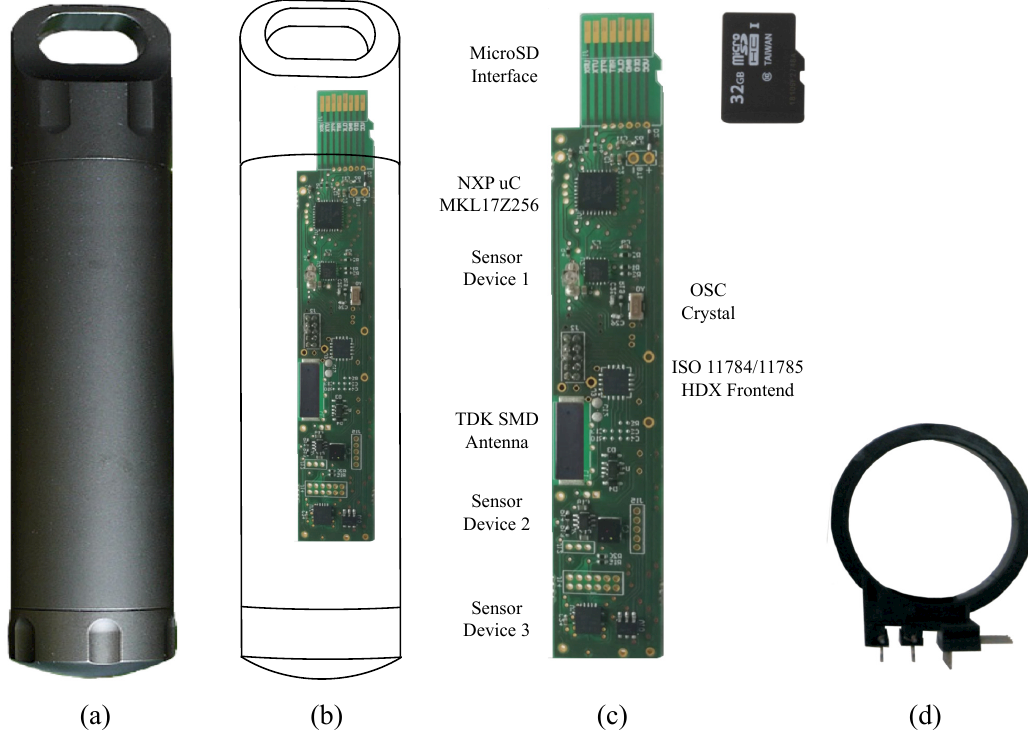
Figure 5. Sensor node used in the experiments: ( a ) Sensor node capsule, ( b ) mainboard and sensor node size comparison, ( c ) Sensor node mainboard details, and ( d ) Top view of the transmission and receiving antenna PLA plastic